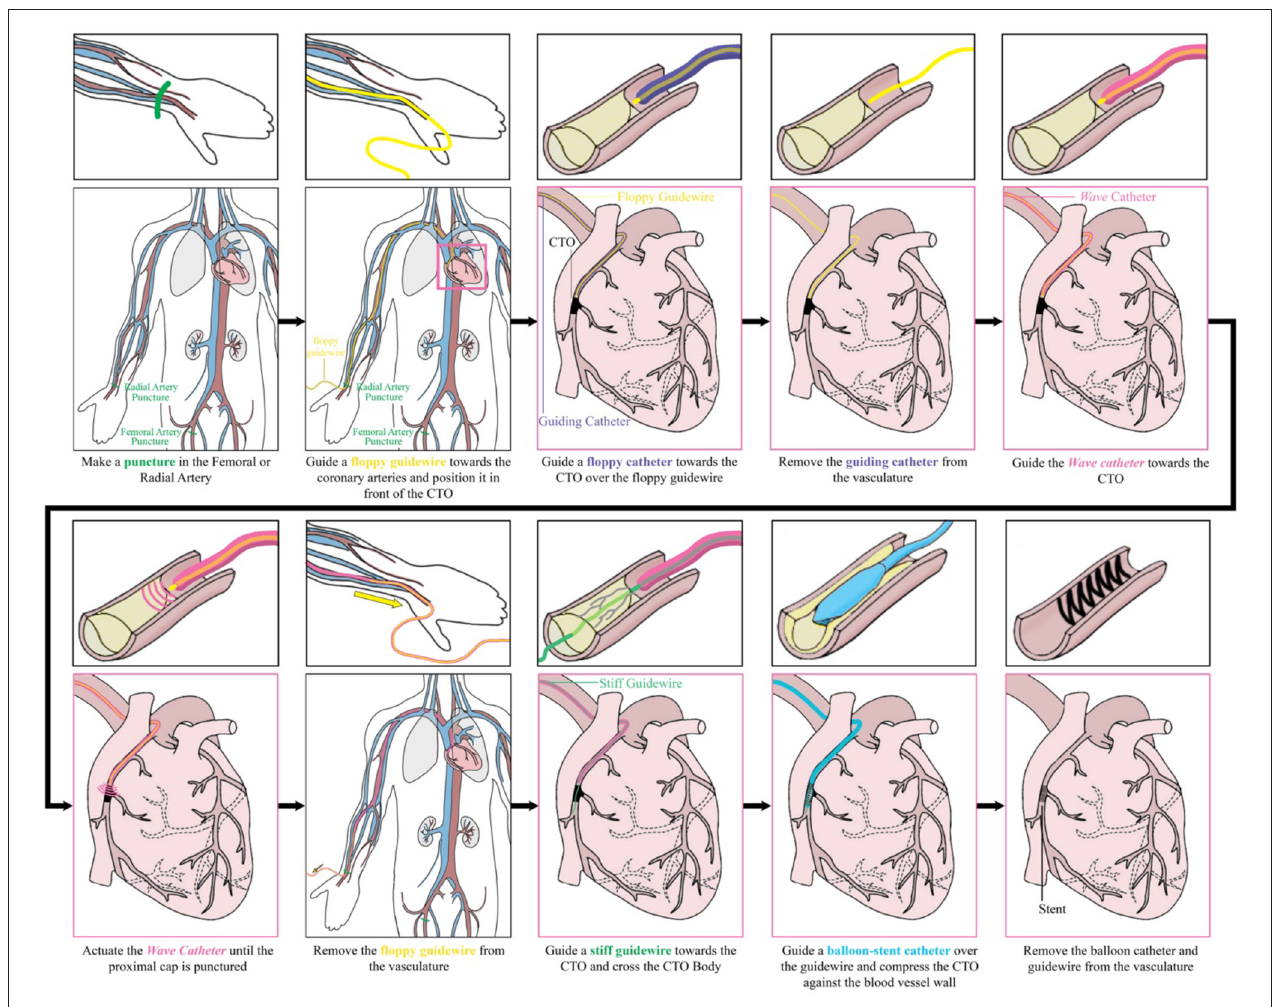
FIGURE 15 | Performing a percutaneous coronary intervention with the Wave catheter: intended